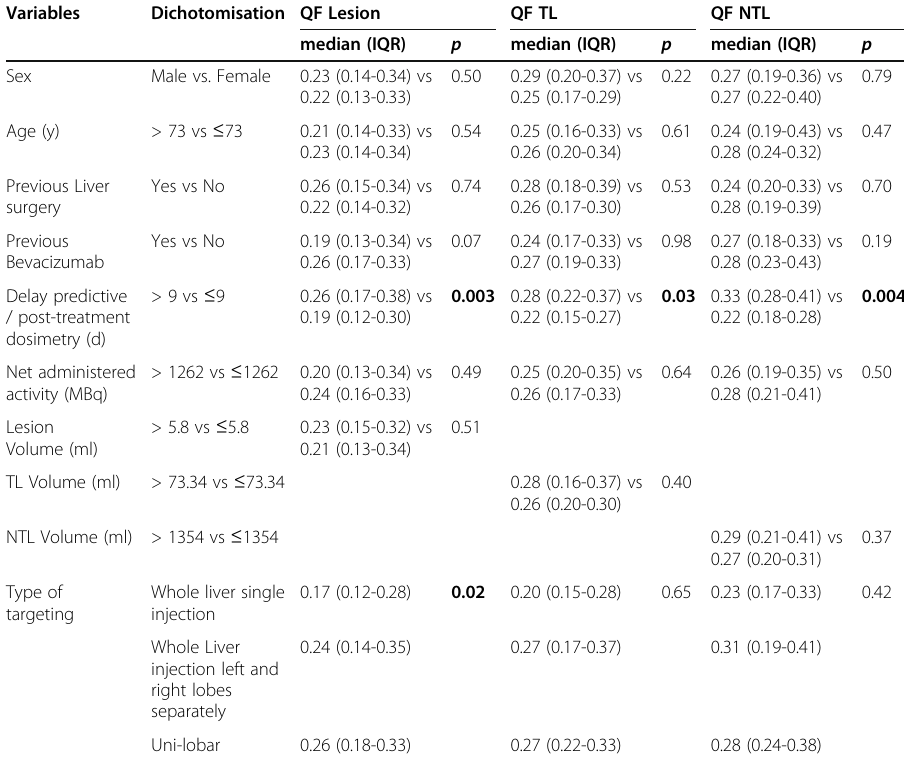
Table 4 Univariate analysis of predictive factors of poor agreement between D Post-treatment-R and D Predicitve-D for Lesion, TL and